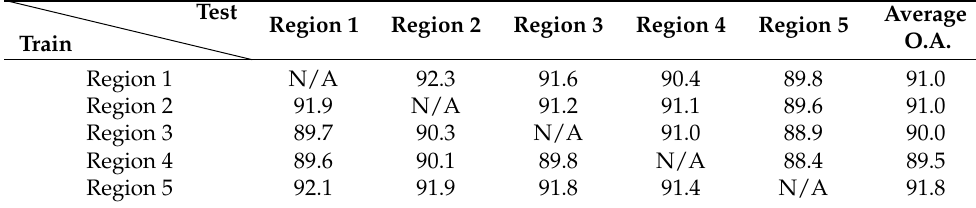
Table 8. The overall accuracy for different training and testing data for VH polarization with ascending orbit mode in 2017.